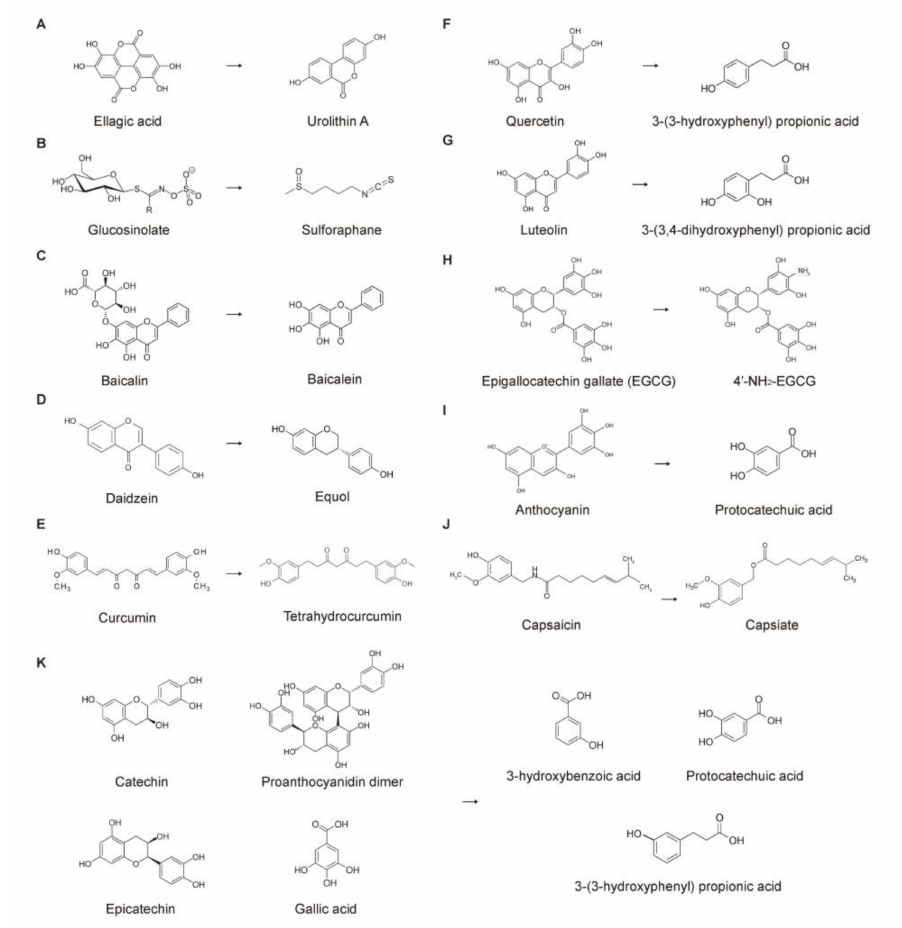
Figure 3. Conversion of phytochemicals by the colonic microbiota. Biotransformation by ( A ) Clostridiales , Ruminococcaceae ; ( B ) Enterococcus casseliflavus CP1, Bacteroides thetaiotaomicron ; ( C ) Escherichia coli ; ( D ) Streptococcus intermedius , Bacteroides ovatus, Ruminococcus productus; ( E ) Escherichia fergusonii , Escherichia coli ; ( F ) Clostridium, Eubacterium ; ( G ) Clostridium, Eubacterium ; ( H ) not determined; ( I ) Bifidobacterium , Lactobacillus ; ( J ) not determined; and ( K ) Bifidobacterium , Lactobacillus , Clostridium